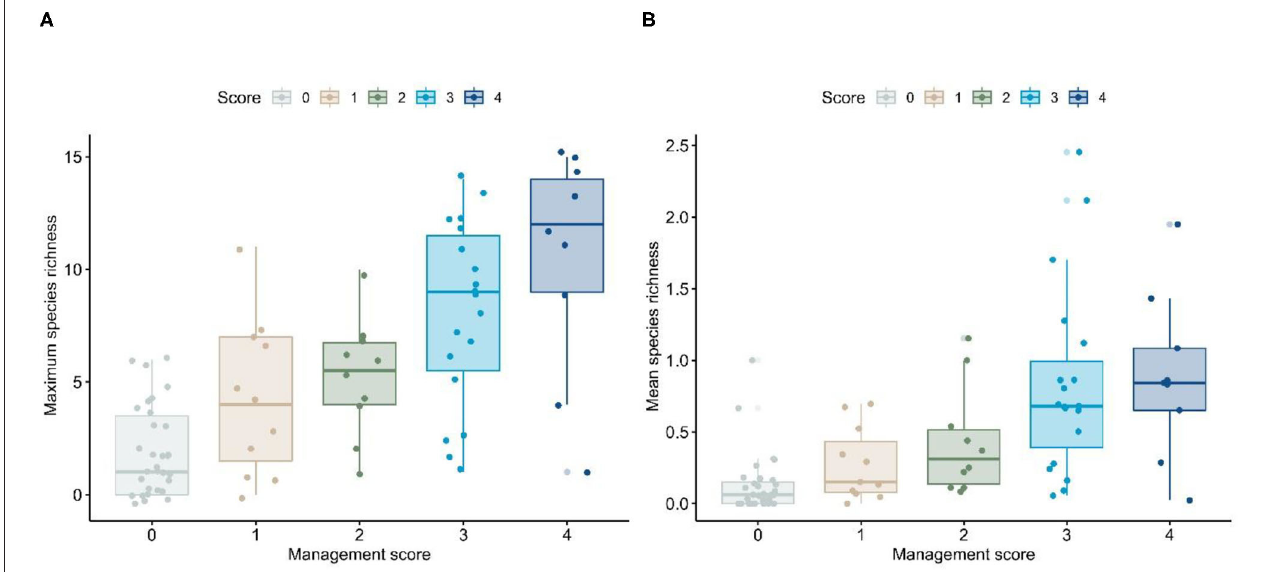
FIGURE 2 | Patterns of (A) maximum and (B) mean species richness based on management score for Los Angeles County cities. Horizontal lines within a box plot represent the median value, whereas the limits of a box represent the first and third quartiles. Lines extending beyond a box represent the general range of data, and dots represent cities. Some dots appear below the zero value. However, there are no values < 0. Rather, we display dots using a “jitter” function to allow visualization of overlapping